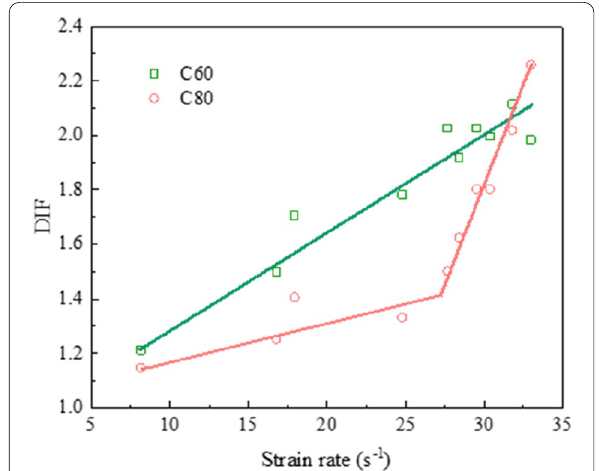
Fig.8 DIF–strain rate relationship for different high-strength